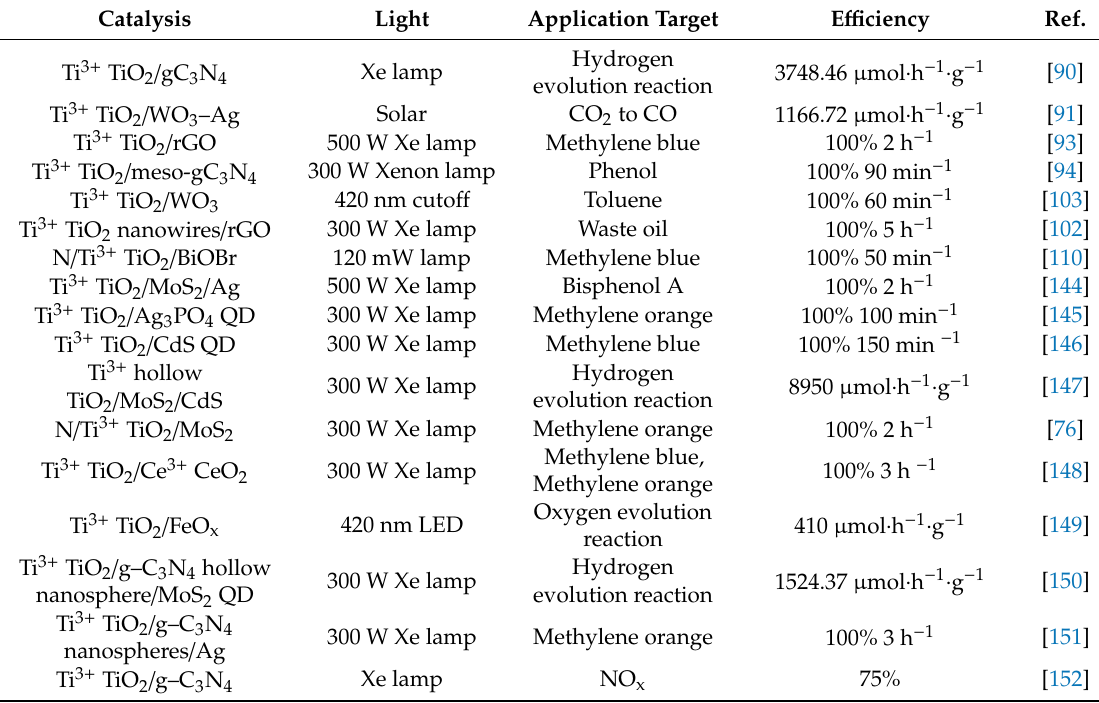
Table 3. Summary of semiconducting coupling with Ti 3 + self-doped TiO 2